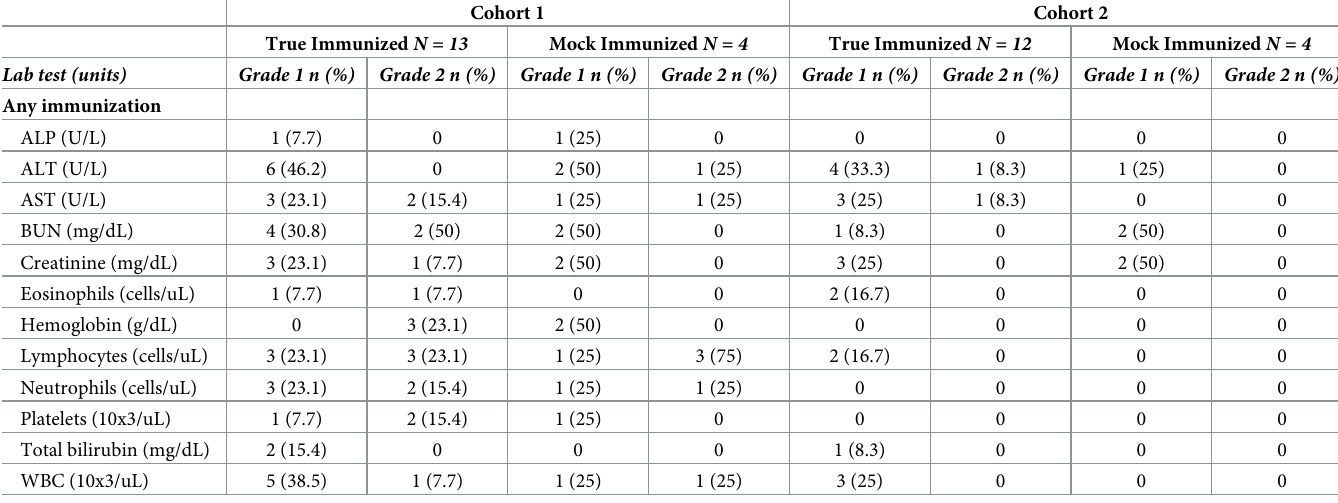
Table 3. Summary of post-immunization laboratory abnormalities by parameter and grade for subjects in both cohorts by true and mock groups over all five immunizations. Cohort 1 Cohort 2 True Immunized N = 13 Mock Immunized N = 4 True Immunized N = 12 Mock Immunized N = 4 Lab test (units)